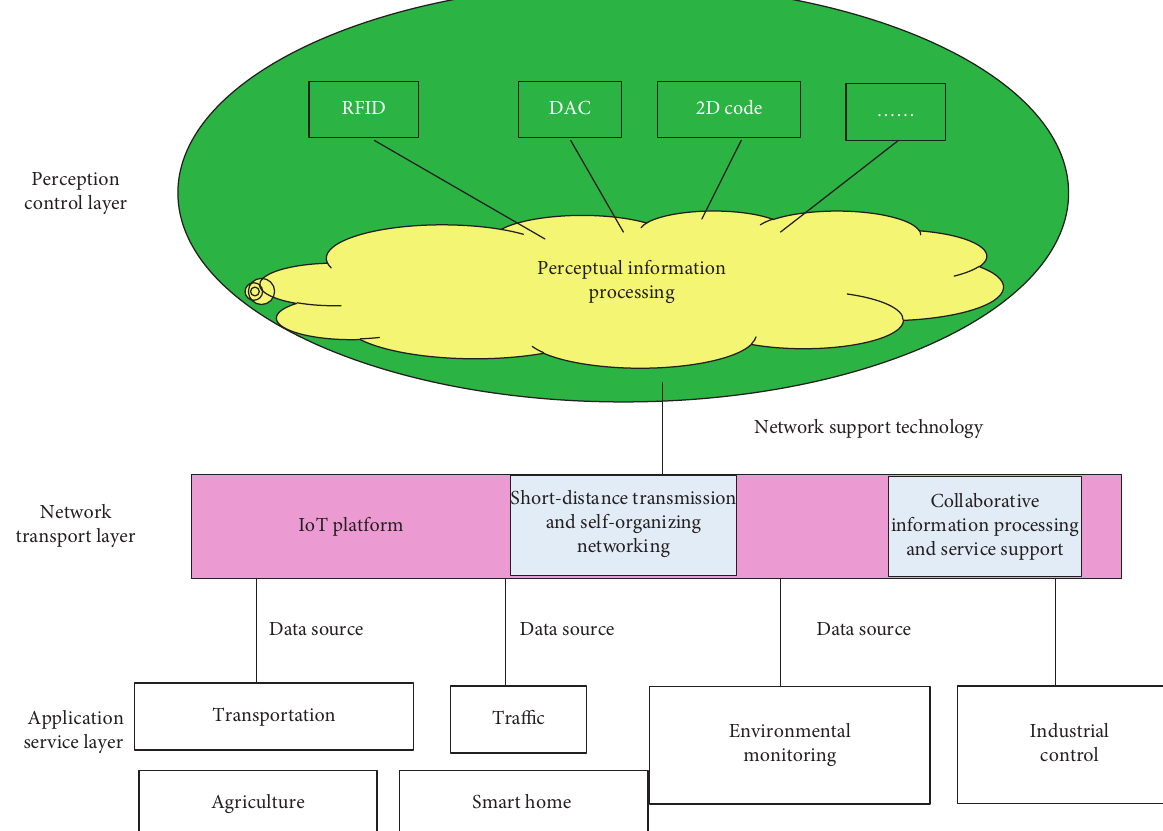
Figure 2: Classification of the Internet of